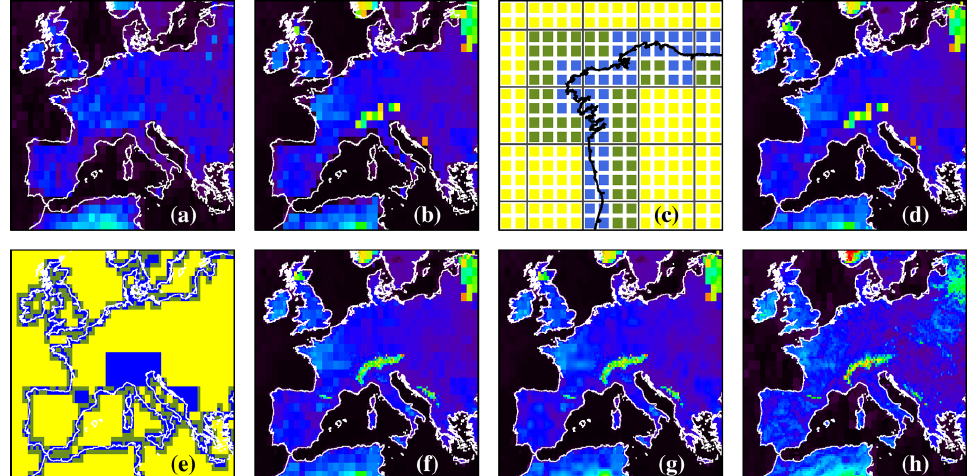
Figure B1. Surface LER at 772nm for the month of March from (a) the GOME-1 database and (b) the previous GOME-2 v1.7 database. Panels (c) and (e) help explain the new dynamic gridding procedure described in Appendix B. Panel (d) presents the GOME-2 database with coastline improvement, (f) does the same but with dynamic gridding also for mountain ranges, and (g) does the same but with the bilinear interpolation scheme applied. Panel (h) presents the Medium Resolution Imaging Spectrometer (MERIS) black-sky albedo as a reference for qualitative comparison. For the GOME-1 database the MIN-LER field was plotted and for the GOME-2 database the MODE-LER field